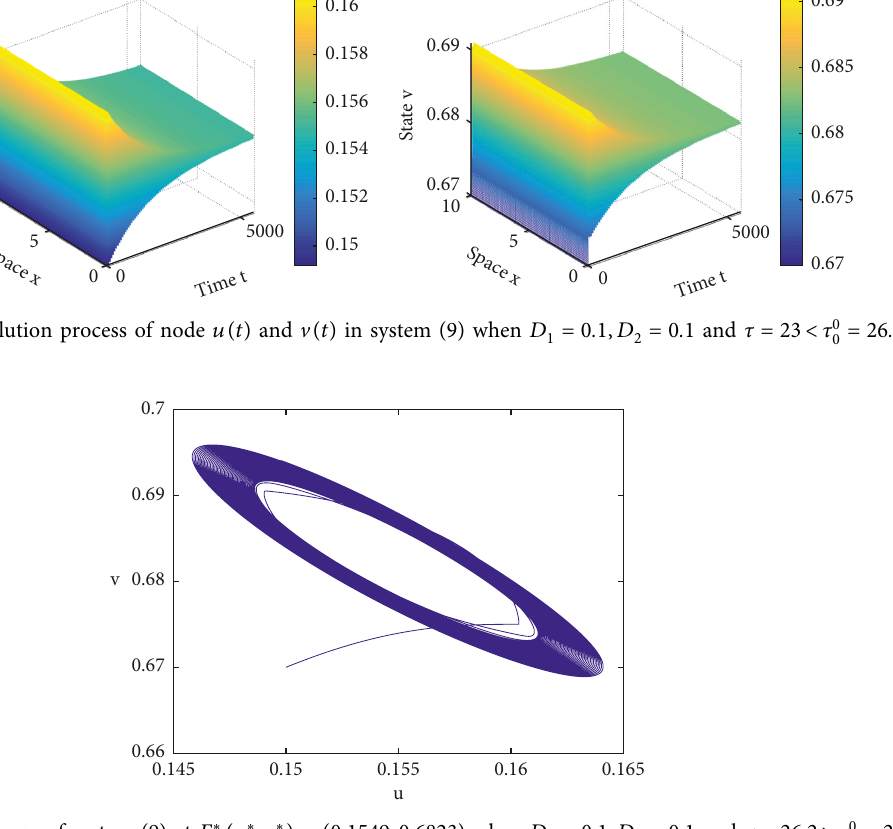
� 0 . 1 ,D � 0 . 1 and τ � 26 . 2 > τ 0 1 2